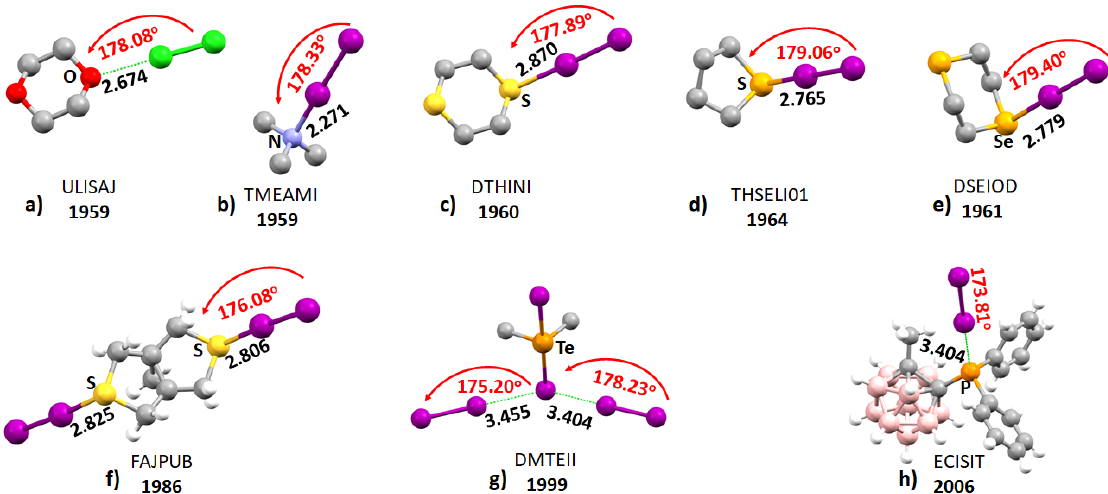
Figure 2. The ball-and-stick and space-filling models of some selected solid-state adducts reported between the middle of the 20th and early this century. These include ( a ) 1,4-Dioxane chlorine (ULISAJ), ( b ) Trimethylamine–iodine (TMEAMI), ( c ) 1,4-Dithiane bis(iodine) (DTHINI), ( d ) Tetrahydroselenophene iodine (THSELI01), ( e ) 1,4-Diselenane bis(iodine) (DSEIOD), ( f ) Dithia(3.3.1)propellane bis(iodine) (FAJPUB), ( g ) Dimethyl-di-iodo-tellurium iodine (DMTEII), and ( h ) 1-Diphenylphosphino-2-methyl-1,2-dicarbadodecaborane(10) hemikis(iodine) (ECISIT). The CSD reference codes and year of publication are indicated for each case: hydrogen in white-gray, oxygen in red, carbon in gray, nitrogen in blue, sulfur in yellow, selenium in light-orange, chlorine in green, iodine in purple, boron in light-pink and phosphorous in orange. The H atoms in several of these adducts are missing in the crystal information file, and hence are not shown.